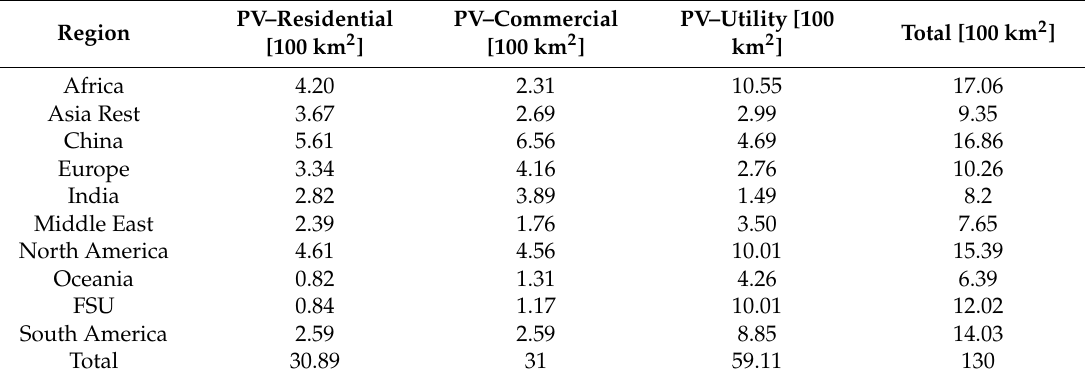
Table 3. Solar PV—Regional